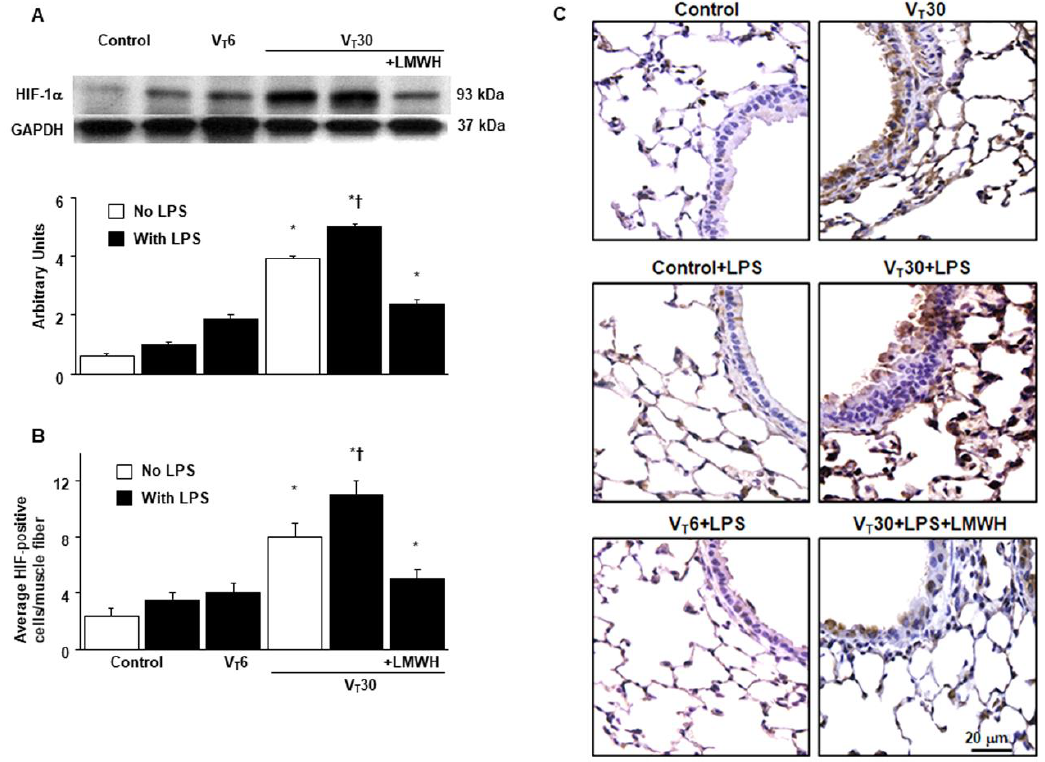
Figure 4. Abrogation of endotoxin-augmented mechanical ventilation-induced HIF-1 α expression by enoxaparin. ( A ) Western blots from the same animals were conducted using antibodies that recognize HIF and GAPDH expression from the lungs of nonventilated control mice and mice ventilated at a tidal volume of 6 or 30 mL / kg for 5 h with or without LPS administration ( n = 5 per group). Arbitrary units were expressed as the ratio of HIF-1 α to GAPDH ( n = 5 per group). ( B , C ) Representative micrographs (400 × ) with HIF-1 α staining of para ffi n lung sections and quantification were from nonventilated control mice and mice ventilated at a tidal volume of 6 or 30 mL / kg for 5 h with or without LPS administration ( n = 5 per group). Enoxaparin, 4 mg / kg, was given subcutaneously 30 min before mechanical ventilation. Scale bars represent 20 µ m. * p < 0.05 versus the nonventilated control mice with LPS; † p < 0.05 versus all other groups.